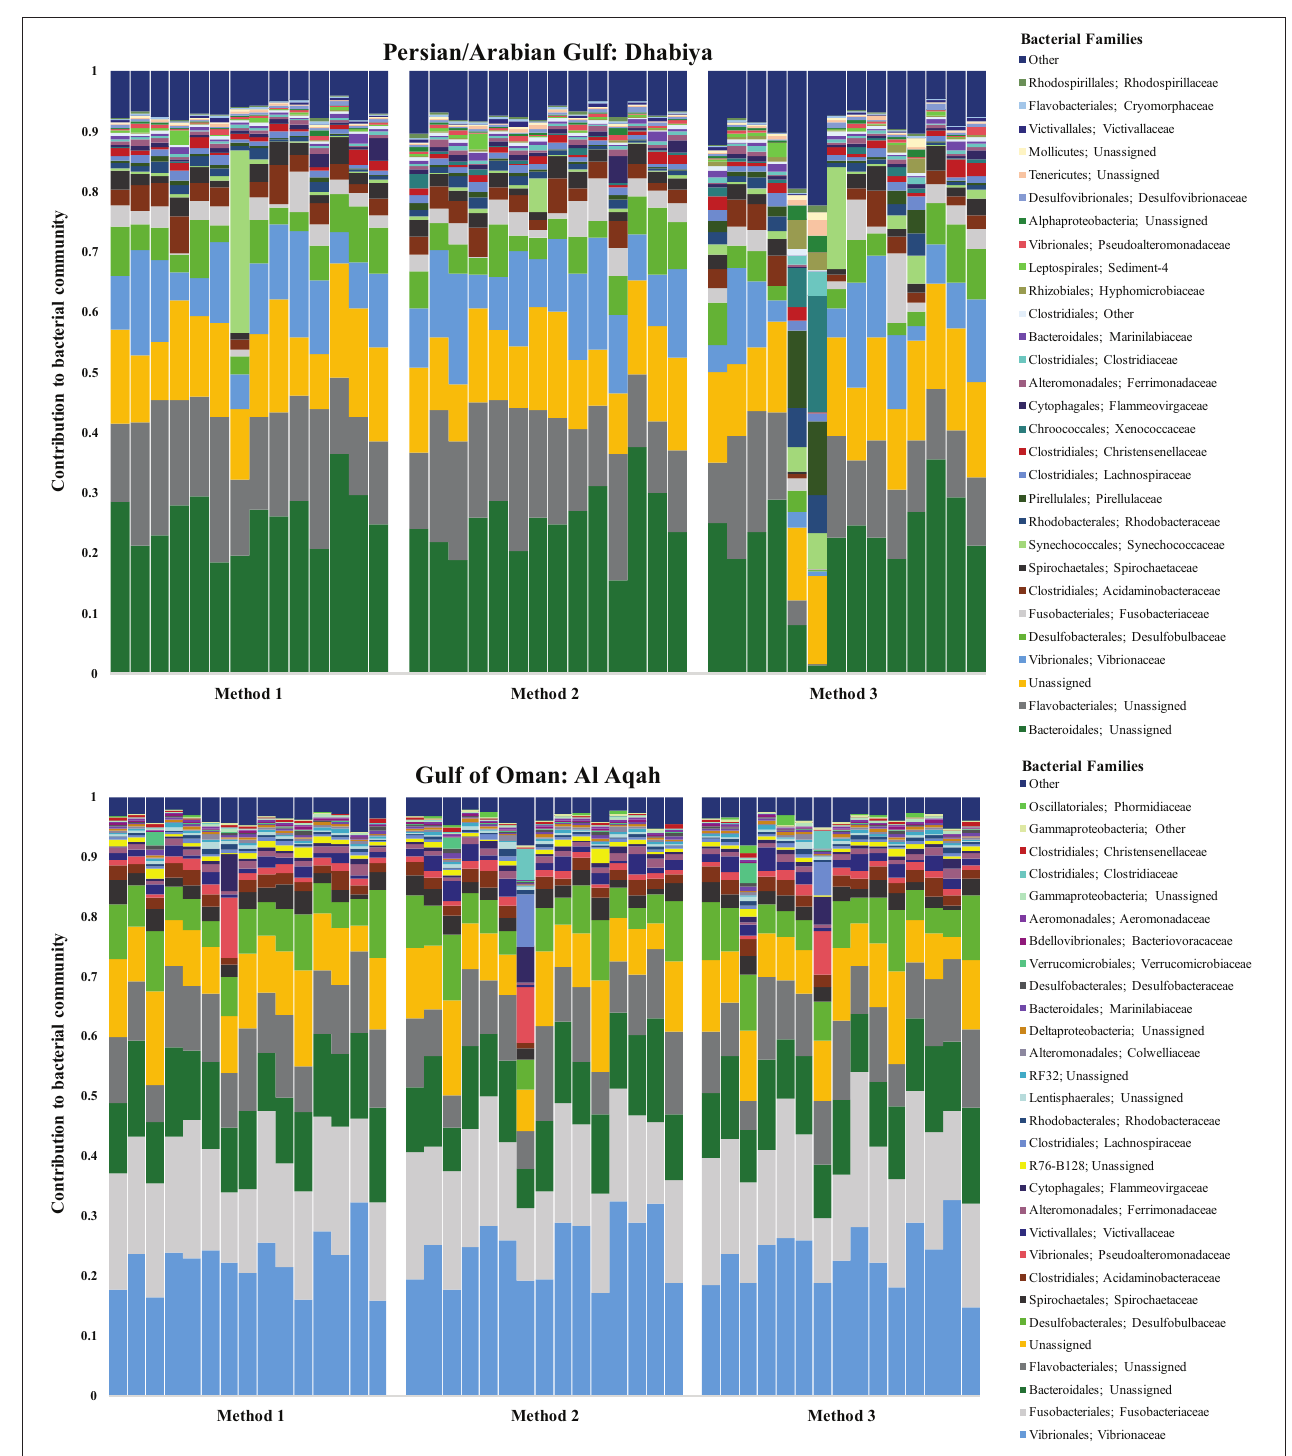
FIGURE 2 | Bacterial community composition of gut contents from Echinometra mathaei from two populations; Persian/Arabian Gulf (on top), Gulf of Oman (on bottom). This taxonomy stacked column plot is characterized to the family level, where possible. Each color represents one of the 29 most abundant families and the remaining taxa are grouped into the category “other.” Samples are grouped by